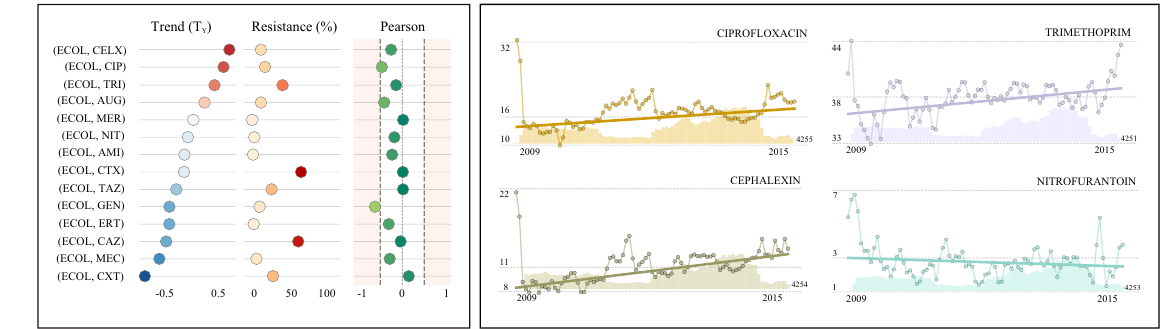
Figure 3. Case study I: E. coli in urine samples. The table presents the resistance index, resistance trend (monthly and yearly), the pearson correlation coefficient, the number of isolates and external resources for validation for each antimicrobial. In addition, the main metrics ( left ) and four examples of resistance time series ( right ) are graphically represented to facilitate